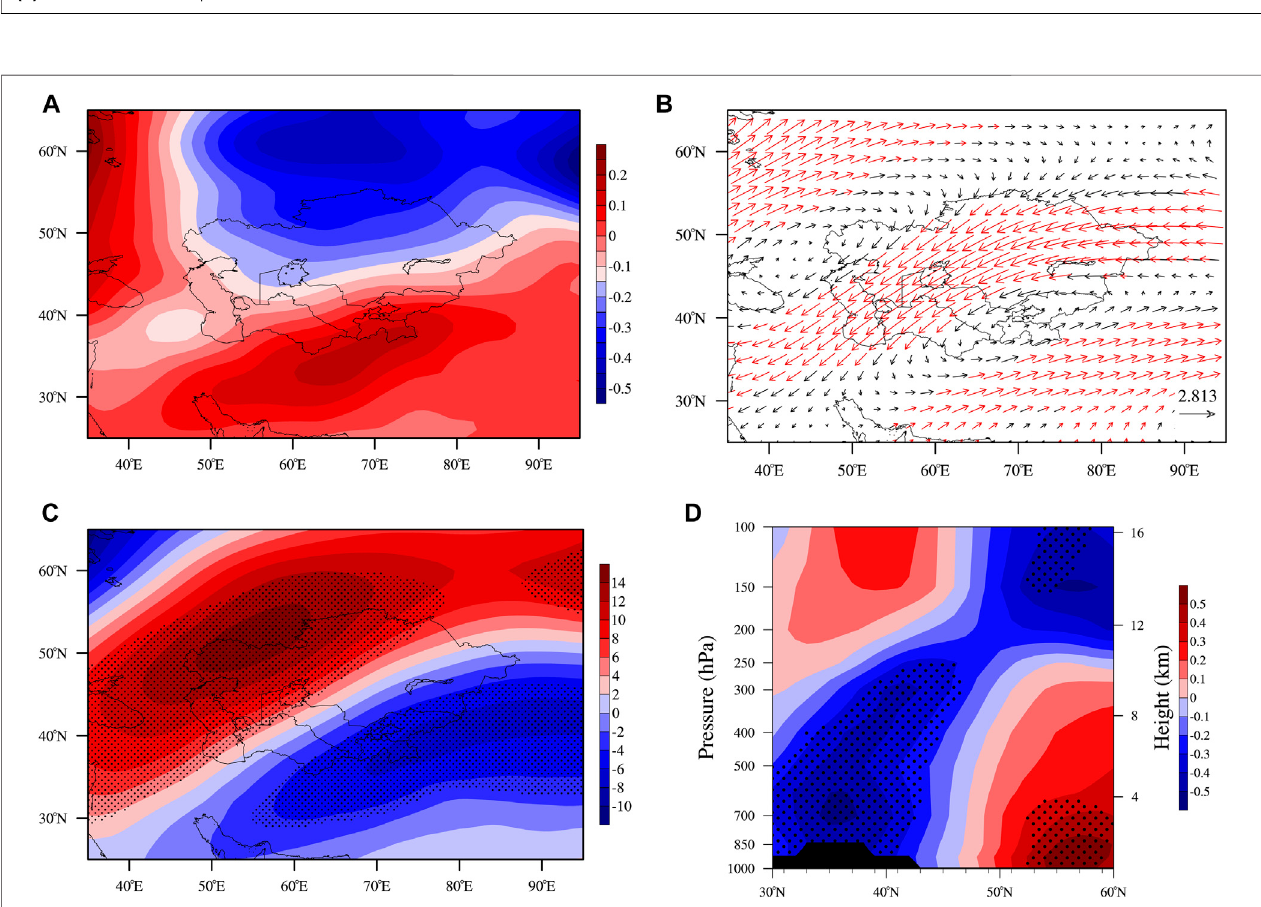
FIGURE 14 | Regression coef fi cient distribution of the TP monsoon index for (A) the 200 hPa summer temperature (shaded areas, unit: K), (B) the 200 hPa wind fi eld, and (C) the 500 hPa geopotential height (shaded areas, unit: m). (D) shows the regression coef fi cient distribution of the TP monsoon index for a zonal pro fi le after theradialaverageofthetemperature.Thedatausedherewerethehistoricalrunof1979 – 2014fromBCC-CMS2-MR.Theredwind fi eldin (B) anddottedareain (A,C,D) are the areas that passed the 90% con fi dence level student ’ s